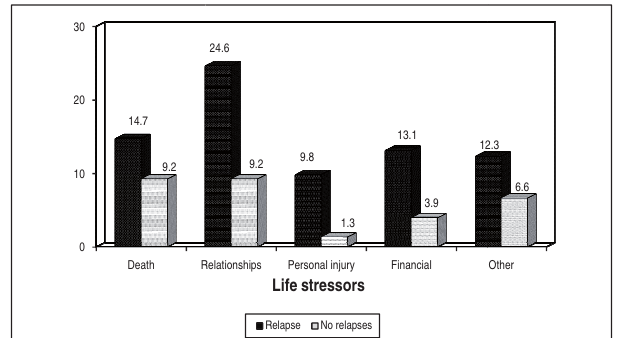
Fig. 2. Life stressors in the study population.